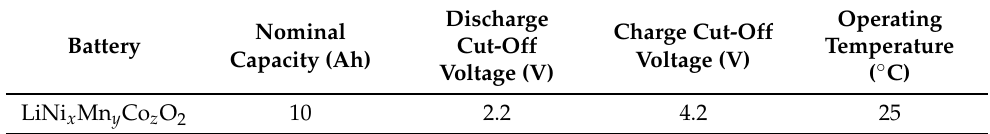
Table 1. Part of the appearance specifications of the lithium-ion